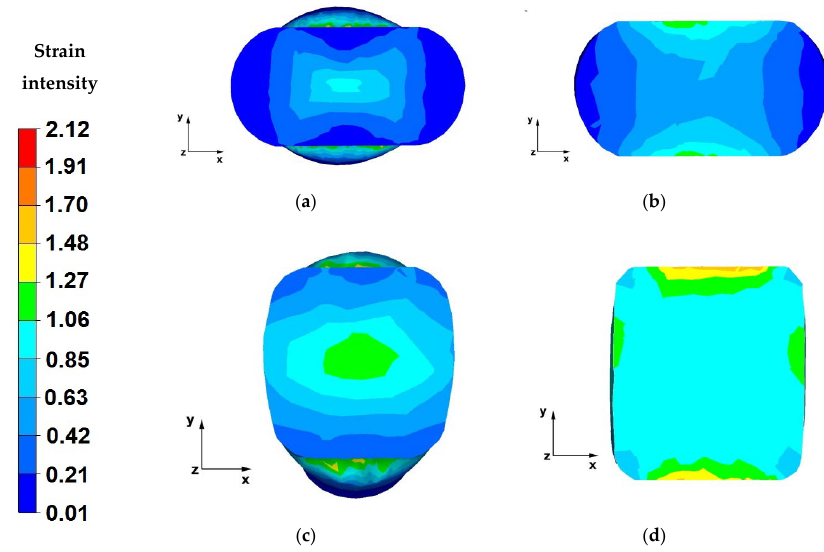
Figure 15. ( a ) Distribution of strain intensities over the cross-section of an AZ91 alloy forged within the first pass, with a relative reduction of 40%, in flat dies; ( b ) Distribution of strain intensities over the cross-section of an AZ91 alloy forged within the third pass, with a relative reduction of 40%, in flat dies; ( c ) Distribution of strain intensities over the cross-section of an AZ91 alloy forged within the fourth pass, with a relative reduction of 40%, in flat dies, after a 90° turning of the forging; ( d ) Distribution of strain intensities over the cross-section of an AZ91 alloy forged within the sixth pass, with a relative reduction of 40%, in flat dies, after a 90° turning of the forging.